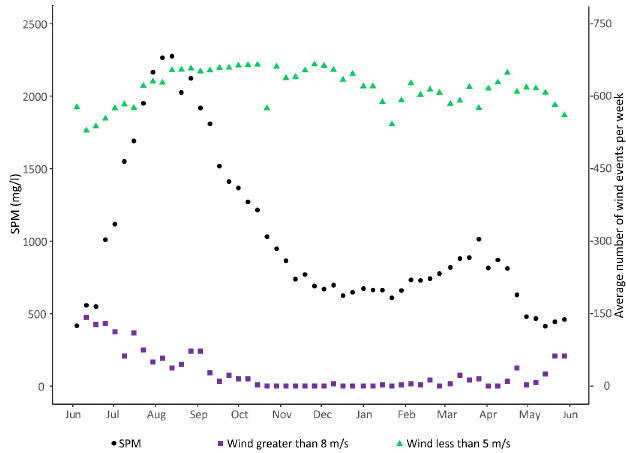
Figure 8. SPM mean annual cycle (average per week, 2000–2016) derived from MODIS data for the Agoufou Lake. Average number of wind events per week with a speed lower than 5 m/s and wind